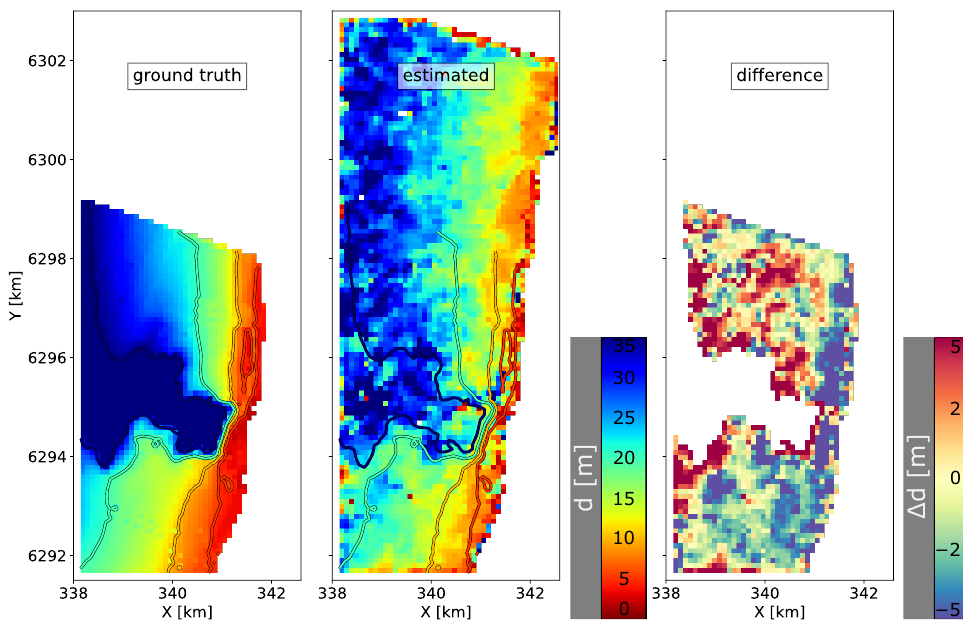
Figure 5. Comparison of depths, d , from ground truth ( left ) against depths estimated from re- constructed satellite video ( centre ). Ground truth depth contours are superimposed on estimated depths for reference. Depths are indicated from red (shallow) to blue (deep) as of centre colour scale. The difference, ∆ d , between estimated depths and ground truth, is presented in the right panel, with red/blue, respectively, denoting under-/overestimation of depth ( right colour scale). Parts where d > 35m are masked and indicate the underwater canyon where waves are unaffected by the